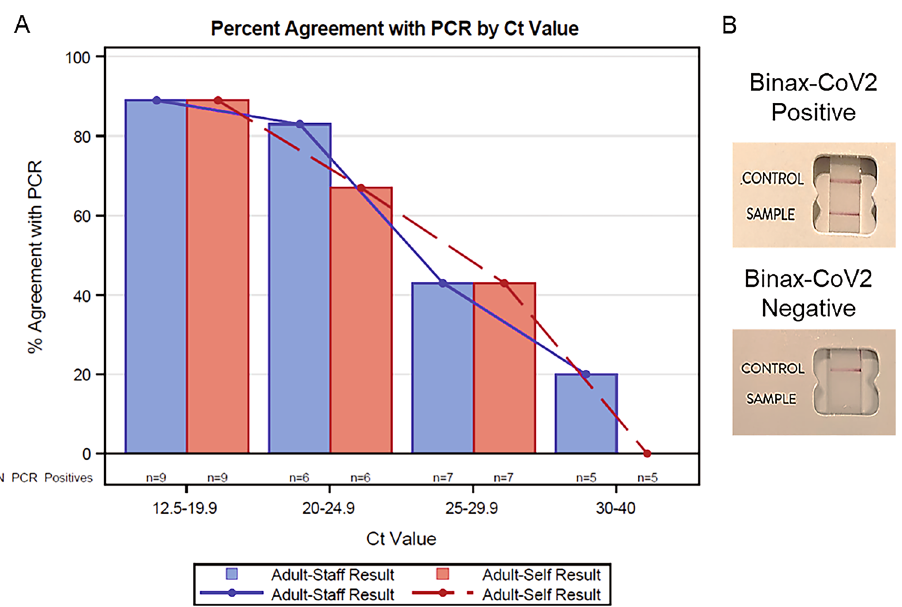
Figure 2. BinaxNOW agreement versus gold standard PCR decreases with rising Ct values and self collected samples. ( A ) Collection of diagnostic samples from the anterior nares was completed by either trained healthcare workers (blue) or individual participants (red). Results of quantitative RT-PCR are presented as Ct scores and used to stratify the presented data. % Agreement was calculated as the percentage of concordant test results per group. ( B ) Pictures of BinaxNOW results for positive and negative